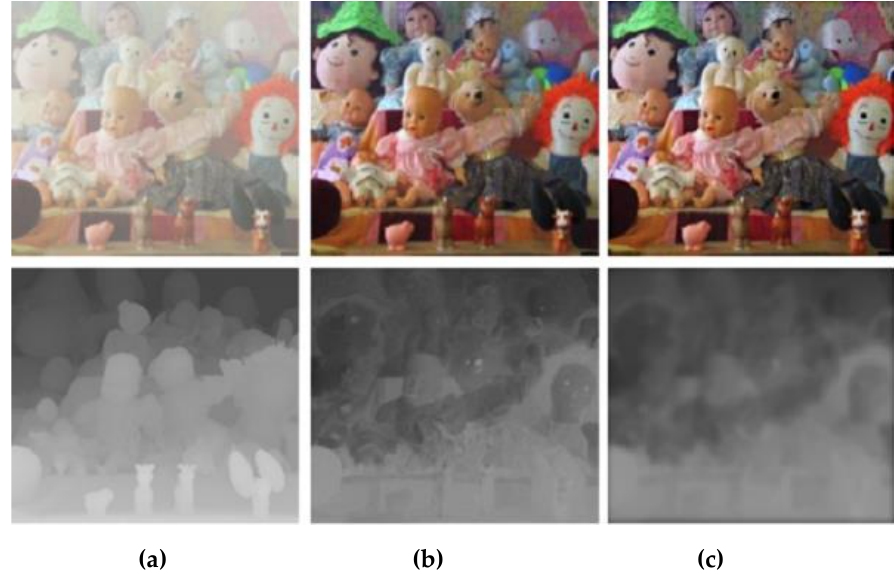
Figure 2. Images for each algorithm and their transmission maps: ( a ) haze image, ( b ) He et al. [40] method, and ( c ) proposed method.